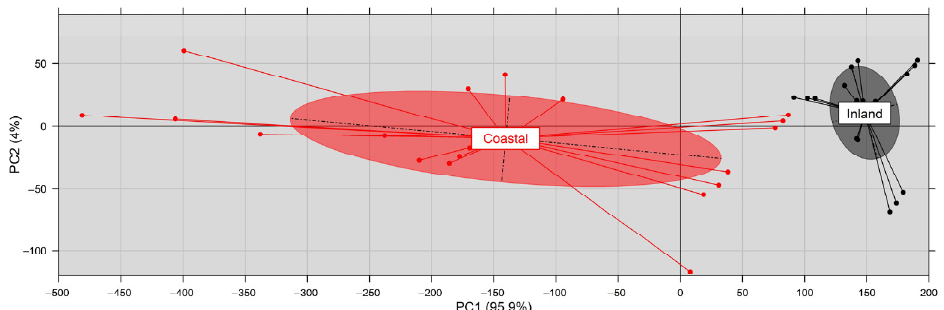
Figure 7. Visualization of PCA based on the considered functional traits of caper pericarps from inland and coastal sites, revealing the grouping of specimens derived from coastal (red) versus inland (grey) habitats.